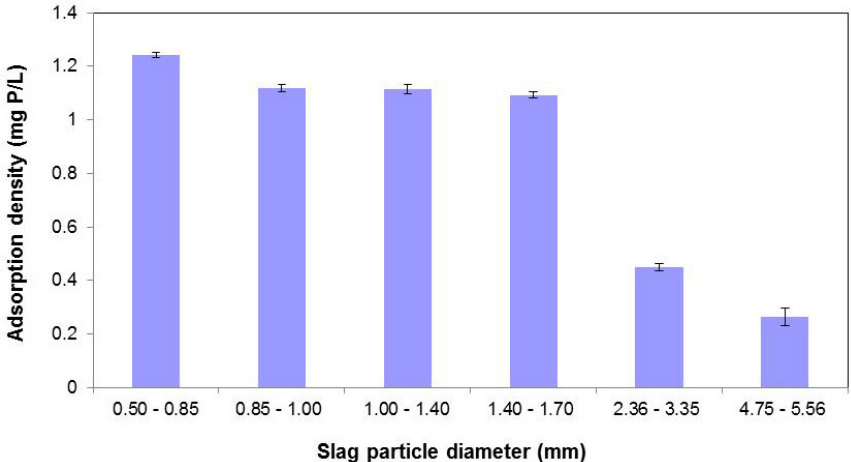
Figure 7. Effect of slag particle diameter on P